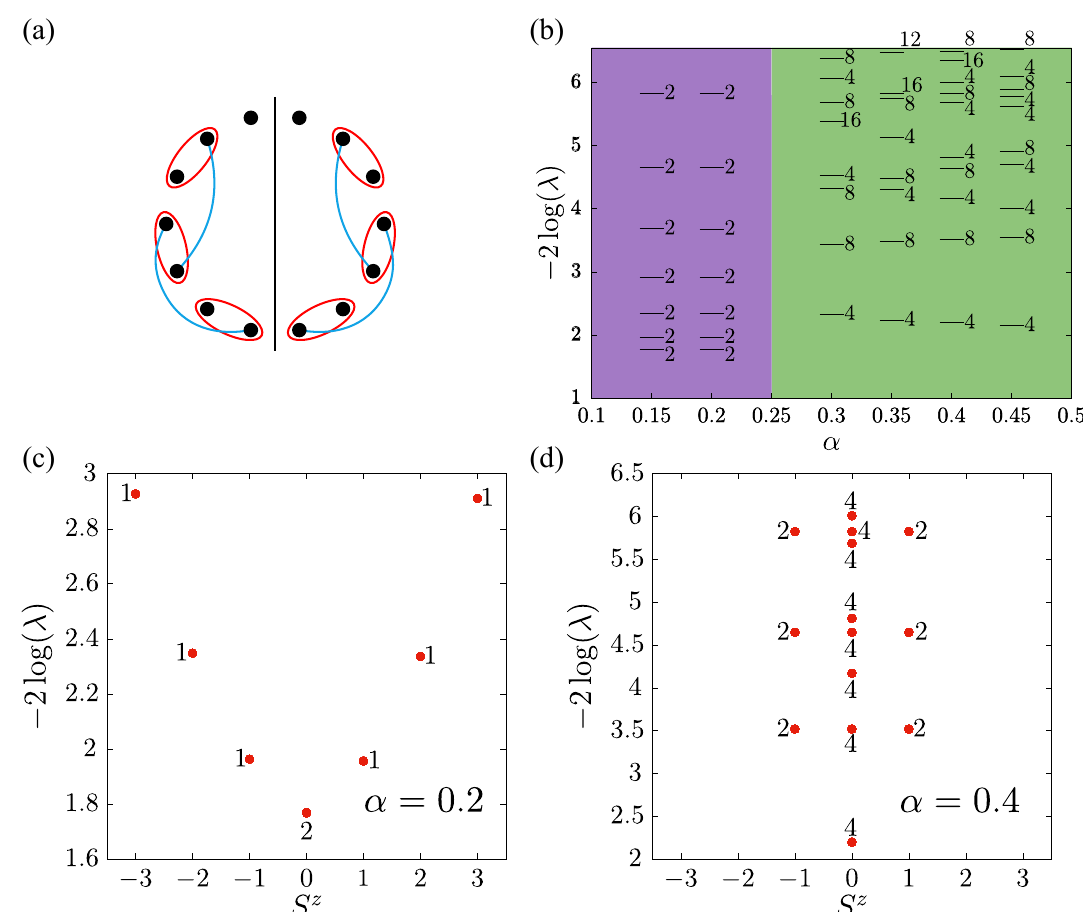
Figure 5: (a) Depiction of the cutting of the system with PBC. Red ellipses represent effective S = 1, blue lines represent singlet formation between third-neighbors. (b) ES as a function of α , lilac area shows the FM region, green one is the -VBS state. D 3 λ are the eigenstates of ρ z for (c) α = 0.2 (FM) and (cid:96) . (c)(d) ES as a function of S (d) α = 0.4 ( D 3